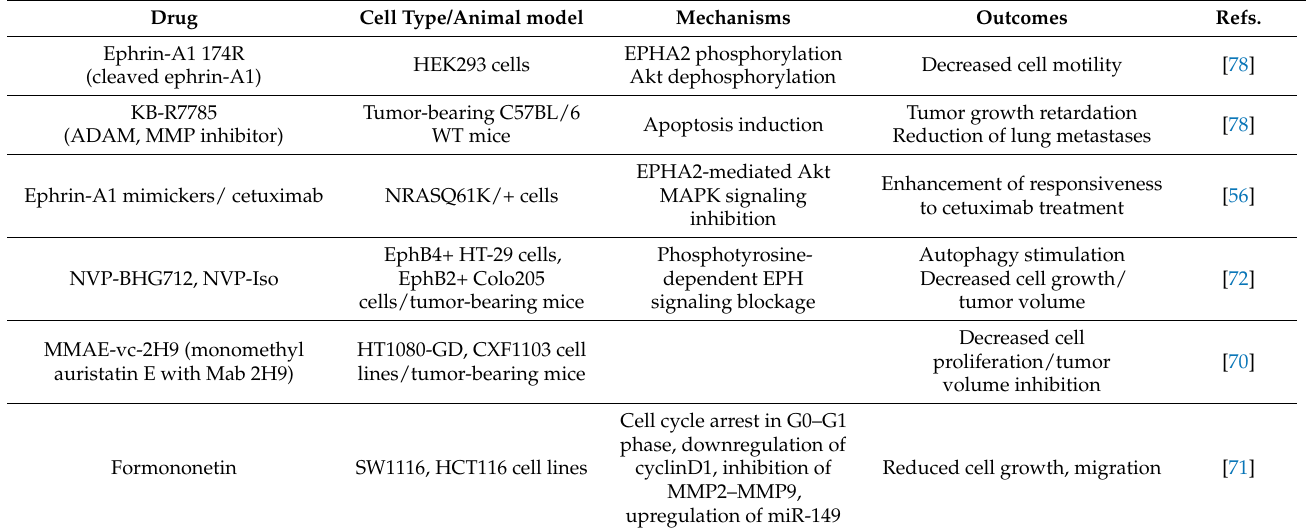
Table 3. Treatment of CRC through EPH/ephrin